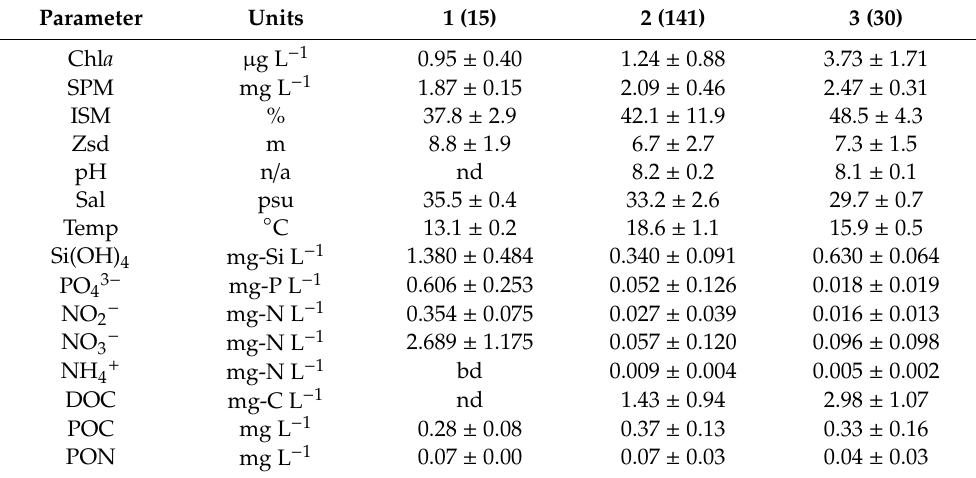
Table 2. A list of the environmental parameters, units and in-situ mean values during the 3 periods (1: spring downwelling; 2: summer; 3: autumn downwelling). Chlorophyll a (chl a ); suspended particulate material (SPM); inorganic suspended material (ISM); Secchi disk depth (Zsd); pH; salinity (Sal); temperature (temp); silicic acid (Si(OH) 4 ), orthophosphate (PO 43 − ); nitrite (NO 2 − ); nitrate (NO 3 − ); ammonium (NH 4 + ), dissolved organic carbon (DOC), particulate organic carbon (POC) and particulate organic nitrogen (PON). nd = not determined, bd = below detection limit (detection limit for: Si(OH) 4 : 0.036 mg L − 1 ; PO 43 − : 0.003 mg L − 1 ; NO 2 − : 0.001 mg L − 1 ; NO 3 − :0.005 mg L − 1 ; NH 4 + : 0.001 mg L − 1 ; DOC: 0.100 mg L − 1 ). We considered only the first 3 m of the depth profiles for pH, salinity and temperature. Square brackets indicate the number of samples for each